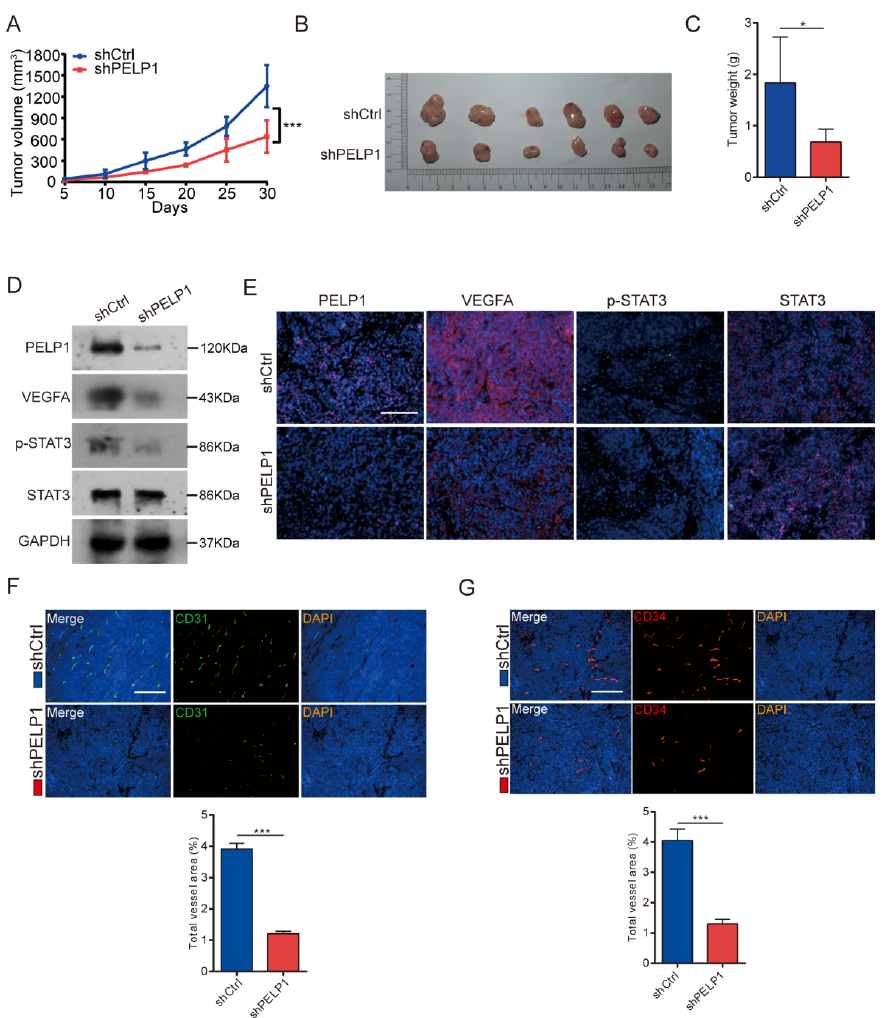
Figure 5. PELP1 suppression attenuates angiogenesis via STAT3/VEGFA axis in vivo: ( A ) Tumor growth curves showed the measure tumor volumes over time. ( B , C ) Representative tumors ( B ) and the bar charts of the weights ( C ) of all tumors harvested at the end of the experiments were shown. ( D , E ) Expression of PELP1, VEGFA, p-STAT3, and STAT3 detected by immunoblotting ( D ) and Immunofluorescent ( E ) in tumors derived from nude mice injected with HCT116 cells stably expressing shPELP1 or shCtrl. GAPDH was used as an internal control. Scale bar: 200 µm. ( F , G ) Representative images of immunofluorescence for MVD (CD31 and CD34) in tumors derived from nude mice injected with HCT116 cells stably expressing shPELP1 or shCtrl (upper panel). Scale bar: 200 µm. Quantification of MVD in the harvested tumors (lower panel). Data are shown as the means of three independent experiments or representative data. Error bars indicate SD.* p < 0.05, *** p < 0.001 by Student’s t -test.